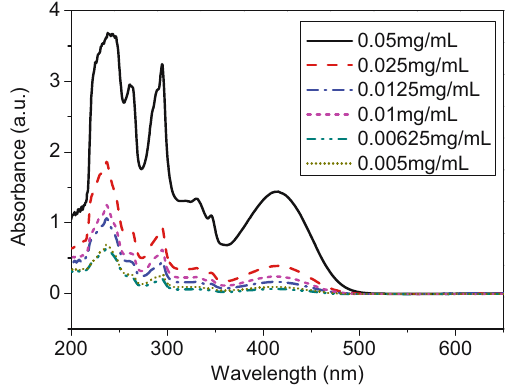
Figure 5: UV - vis absorption spectra of polymer P2 in THF at di ff erent concentrations.